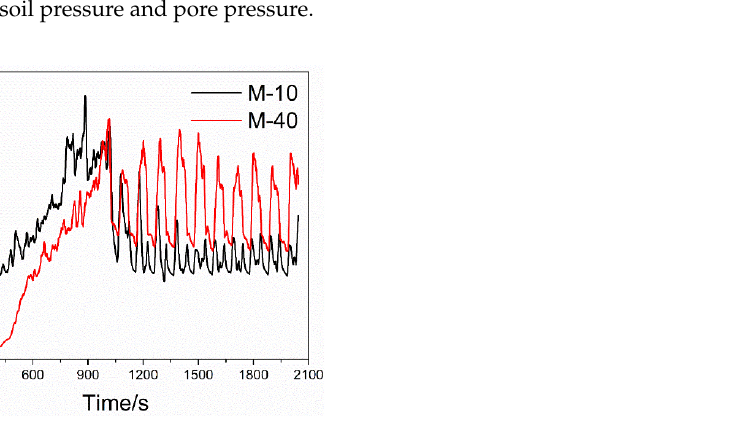
Figure 19. Lateral soil pressure. Note: M-10 denotes the soil pressure sensor 10 cm from the end, and M-40 denotes the sensor 40 cm from the end.